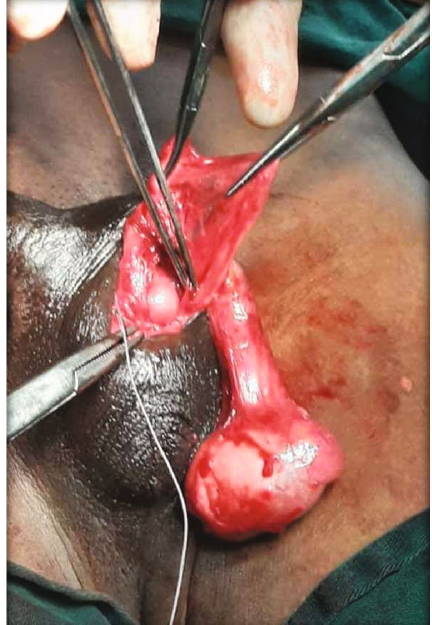
Figure 7: Transseptal orchidopexy of the right testis and closure of the scrotal septum.